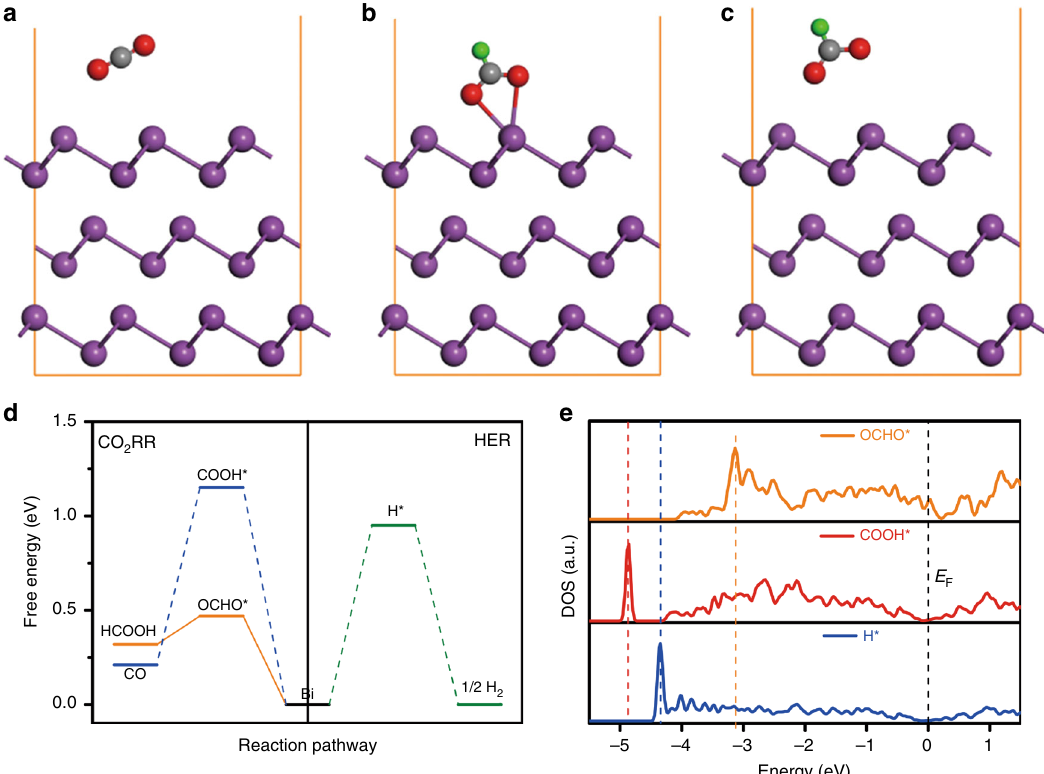
Fig. 4 DFT simulation of the CO 2 RR process on Bi (001) plane. a – c Optimized geometric structure of a CO 2 , b OCHO* adsorbate and c HCOO − , where Bi, C, O, and H atoms were presented by purple, gray, red, and green spheres, respectively; d free-energy diagrams for HCOO − , CO, and H 2 formation on Bi (001) plane; e projected p -orbital DOS of the Bi site with OCHO*, COOH*, or H* adsorbate, the Fermi level ( E F ) was at 0 eV, E p in OCHO*, and COOH* and H* were highlighted with yellow, blue, and green dashed lines,